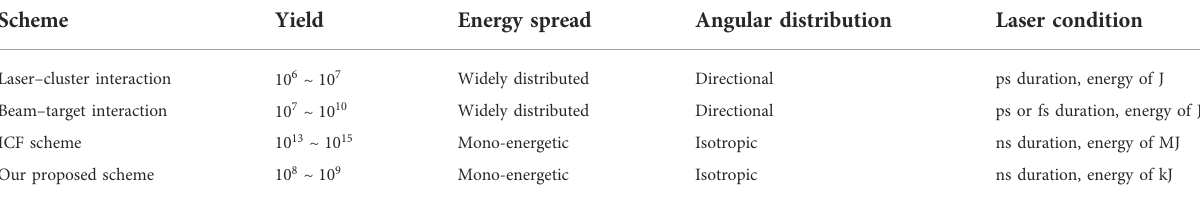
TABLE 1 The comparison of the laser-driven neutron